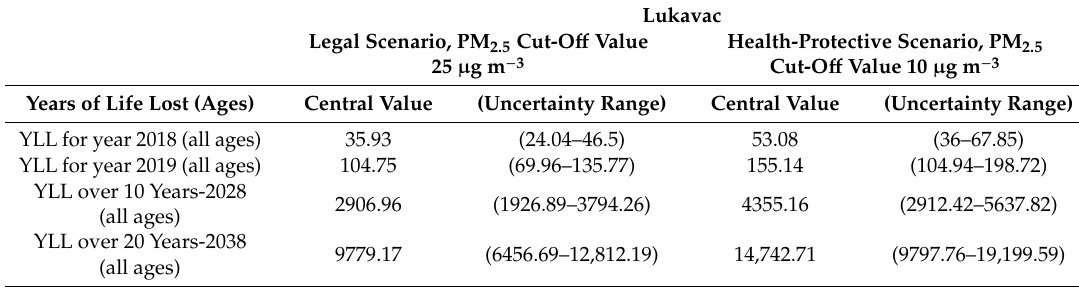
Table 5. Years of life lost (YLL) due to premature mortality for Lukavac, against two cut-o ff scenarios.